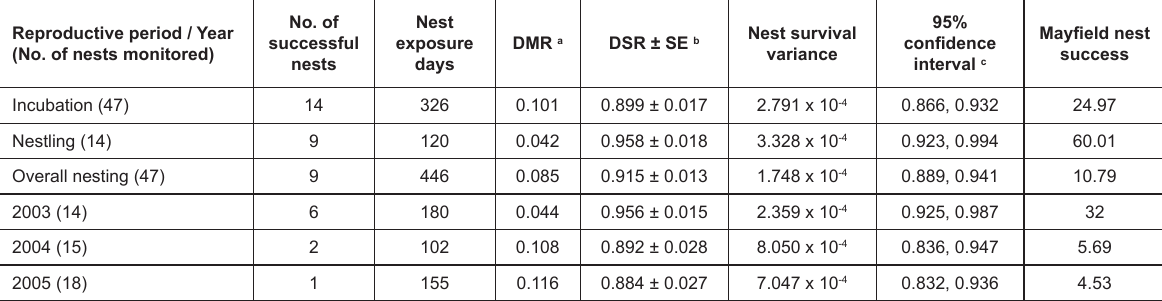
Nest exposure days are the total number of days that active nests were monitored; a DMR - daily mortality rate; b DSR - daily survival rate; c confidence interval for daily probability of nest survival.